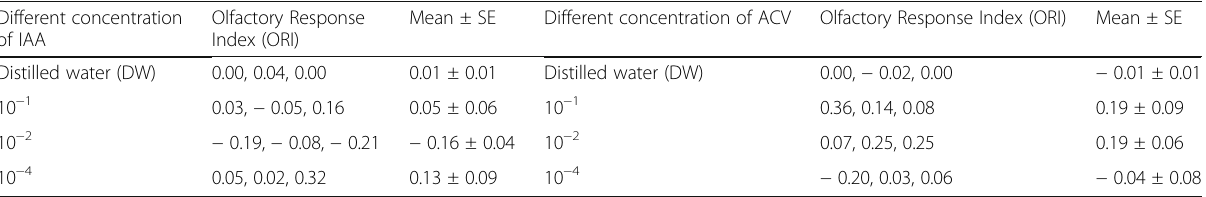
Table 1 Olfactory Response Index (ORI) of 2nd instar larvae of Zaprionus indianus for different concentrations of iso-amyl acetate (IAA) and apple cider vinegar (ACV) Different concentration Olfactory Response Mean ± SE of IAA Index (ORI)